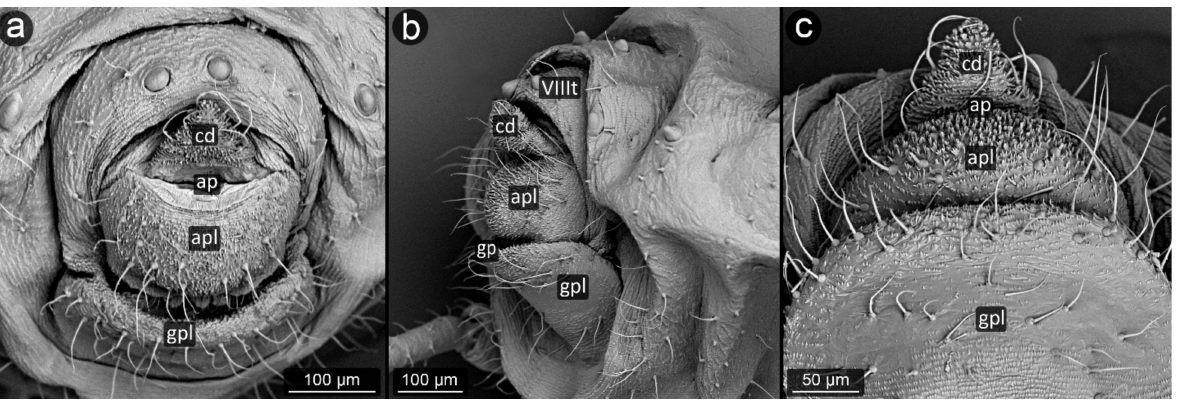
Figure 27. Perianal structure of Dysaphis sorbi in SEM; ( a )—rear view, ( b )—lateral view, ( c )— abdominal